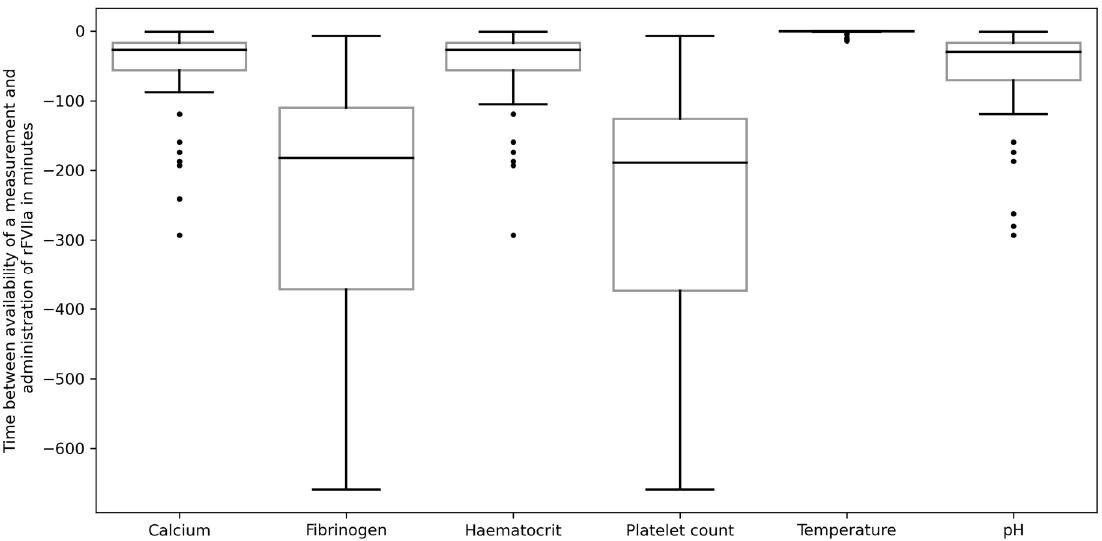
Figure 4. Time between the availability of a measurement and the administration of rFVIIa in minutes. Temperature was measured using a temperature catheter; calcium, hematocrit, and pH values were measured via point-of-care blood gas analysis, whereas fibrinogen levels and platelet counts were measured at the central